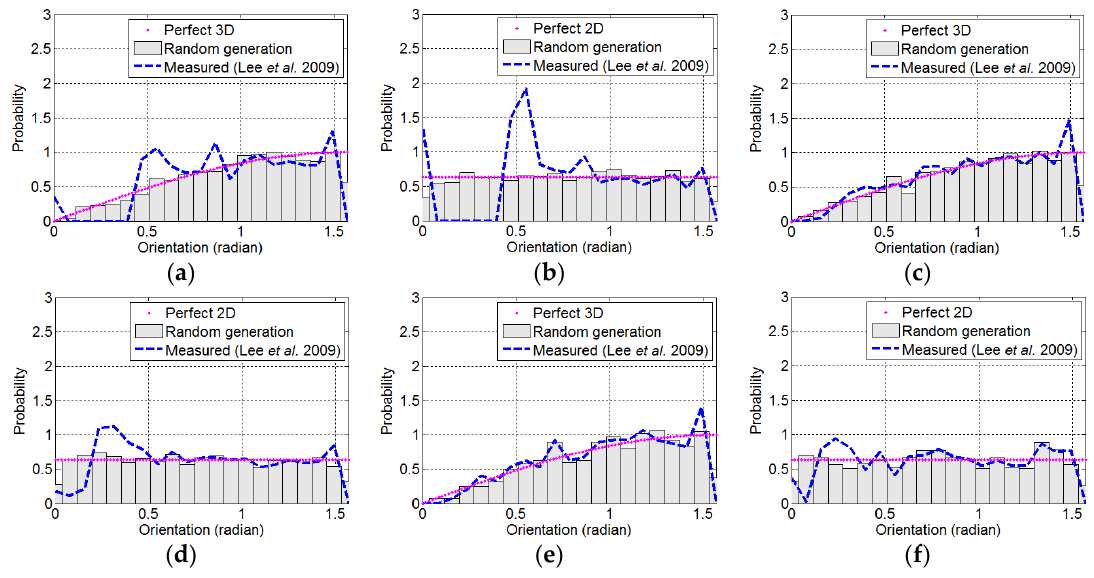
Figure 10. Probability density functions of the orientation of randomly ‐ generated artificial fibers and the orientation measured by the image analysis technique proposed by Lee et al. (2009): ( a ) I05 ‐ 3;